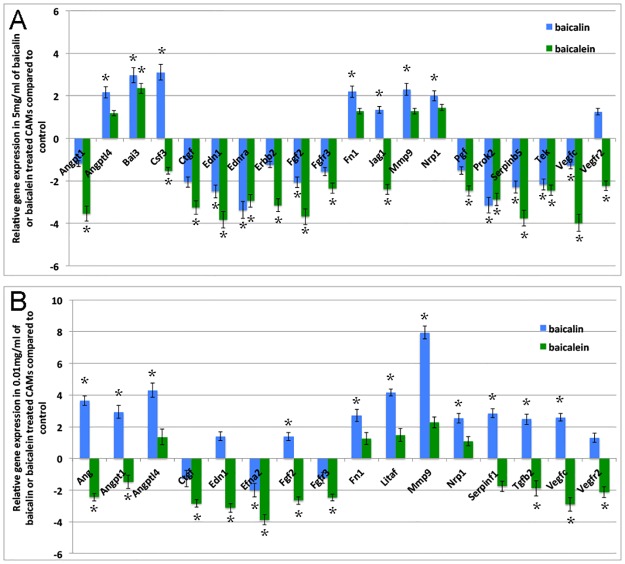
Relative expression of angiogenic genes in high and low dose of baicalin and baicalein treated CAM.(A) Relative transcript levels (y-axis shows fold changes) in high dose of baicalin and baicalein treated CAM compared to controls. Control is assigned a value of 0. Twenty-seven of 84 genes showed statistically significant changes of >2.0-fold (P < 0.05) to respond high dose of baicalin (12 genes) and baicalein (15 genes) treatment. (B) Relative transcript levels (fold changes) in low dose of baicalin and baicalein treated CAMs compared to controls. Twenty of 84 genes showed statistically significant differences of >2-fold (P < 0.05) to respond low dose of baicalin (11 genes) and baicalein (9 genes) treatment. Error bars show mean ±SE, and asterisks denote significant differences between each treatment group and control group (*P ≤ 0.05, **P ≤ 0.01). Sample size for each treatment: n = 4.